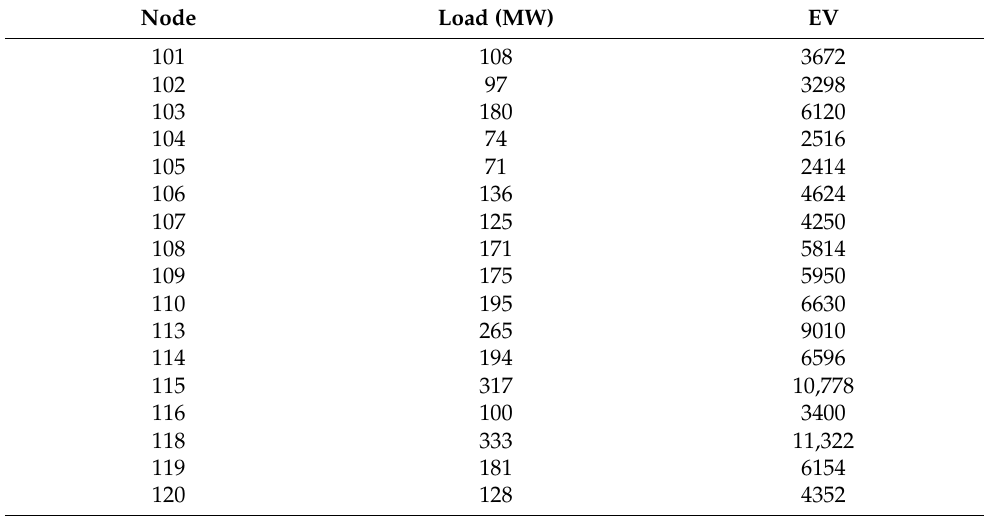
Table 4. EV nodal distribution at 10% penetration of LDVs in RTS-GMLC Region 1 based on the nodal peak load